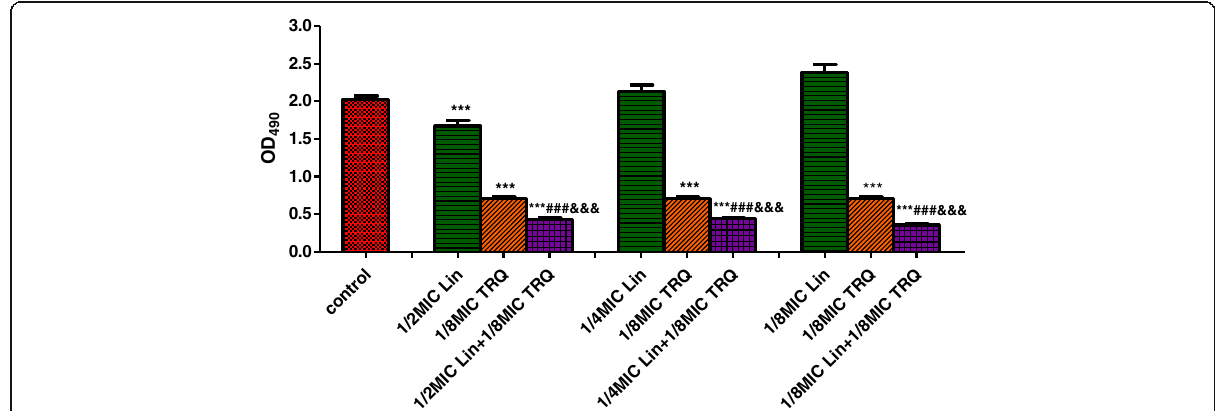
Fig. 4 Effect of TRQ combined with linezolid on the preformed MRSA biofilm. Results are presented as the mean ± standard deviation of triplicate assays. (***p < 0.001 vs. control group; ###p < 0.001 vs. linezolid group; &&&p < 0. 001 vs. TRQ